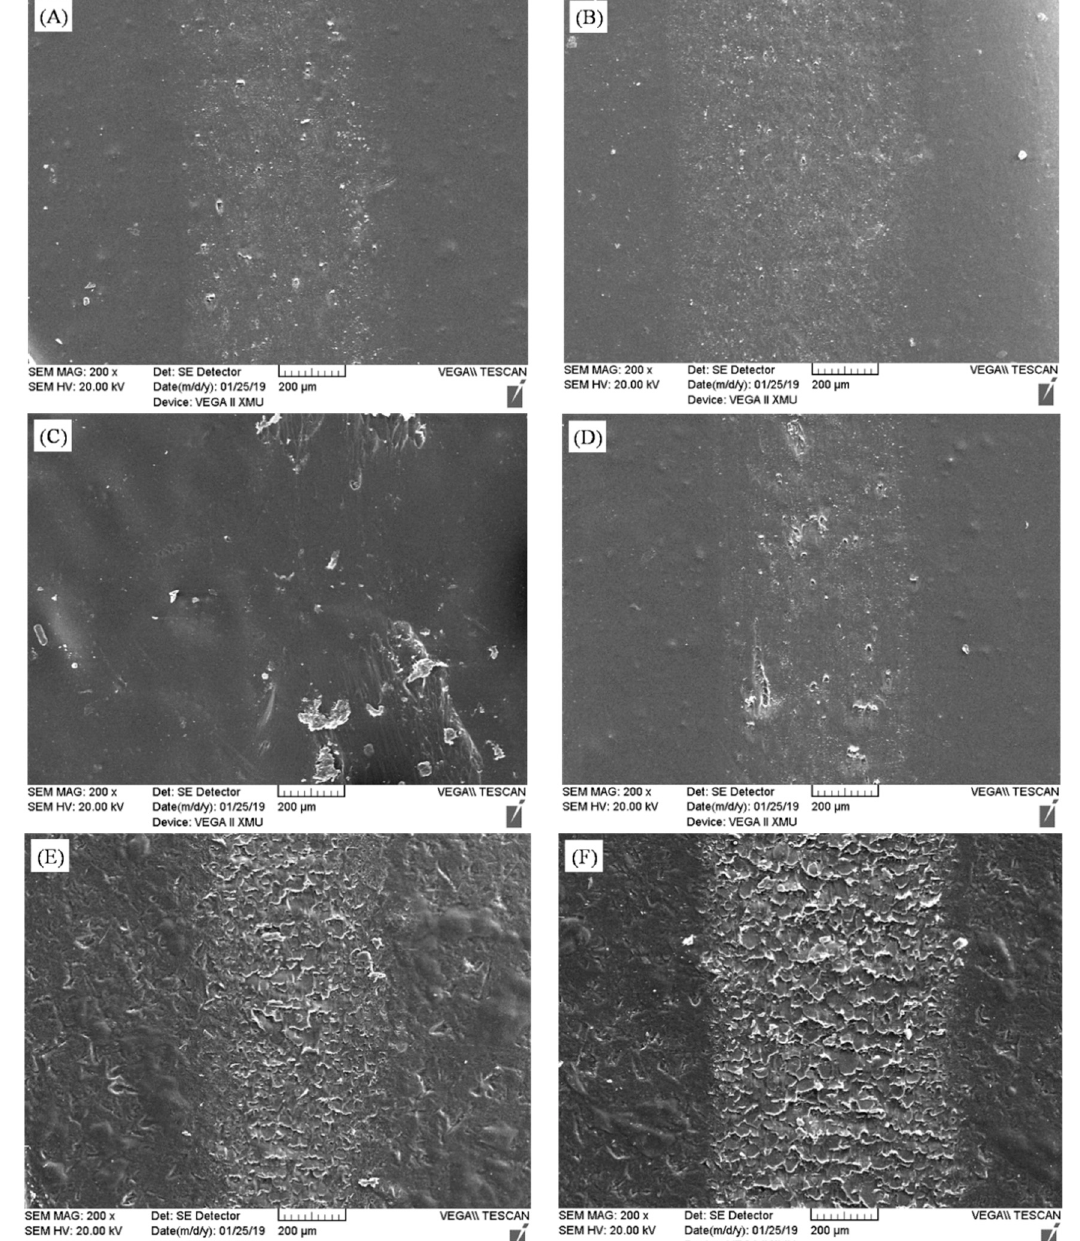
Figure 6. Wear track morphologies of coatings with different MWCNT contents: ( A ) ESC with 0 wt% MWCNT, ( B ) ESC with 0.3 wt% MWCNT, ( C ) ESC with 0.6 wt% MWCNT, ( D ) BrC with 0 wt% MWCNT, ( E ) BrC with 0.3 wt% MWCNT, and ( F ) BrC with 0.6 wt% MWCNT.